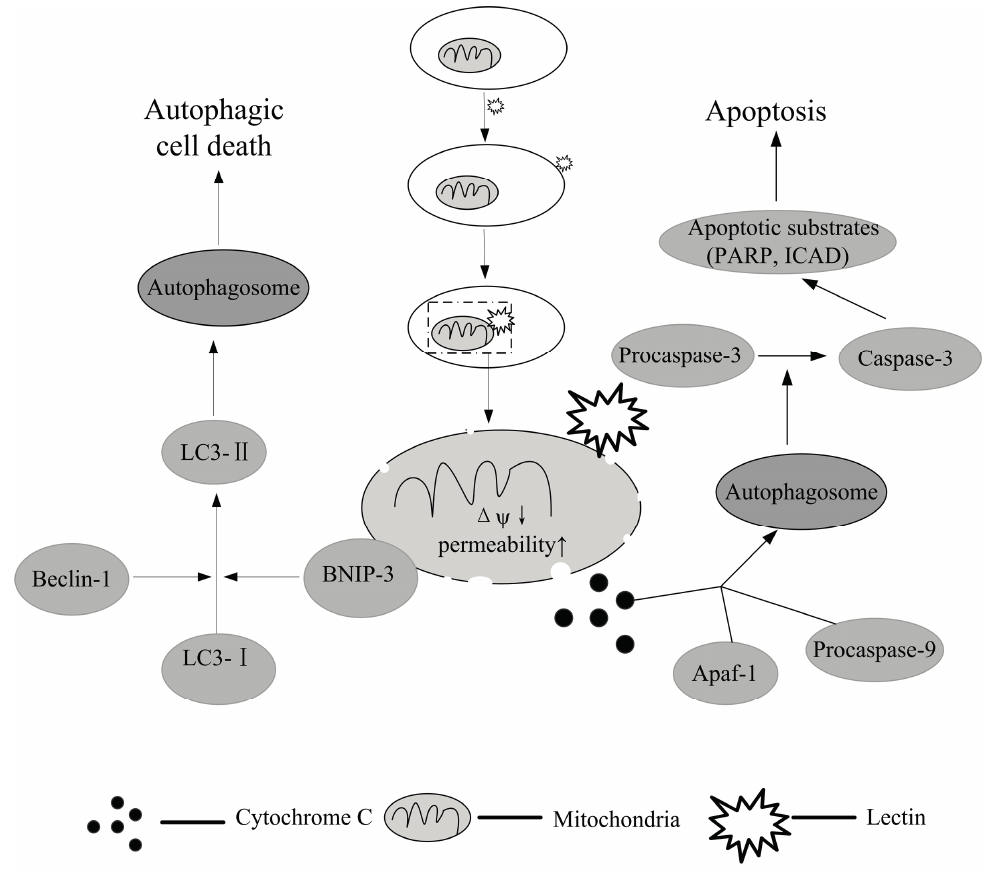
Figure 1. Mechanisms of apoptosis and autophagy induced in tumor cells by